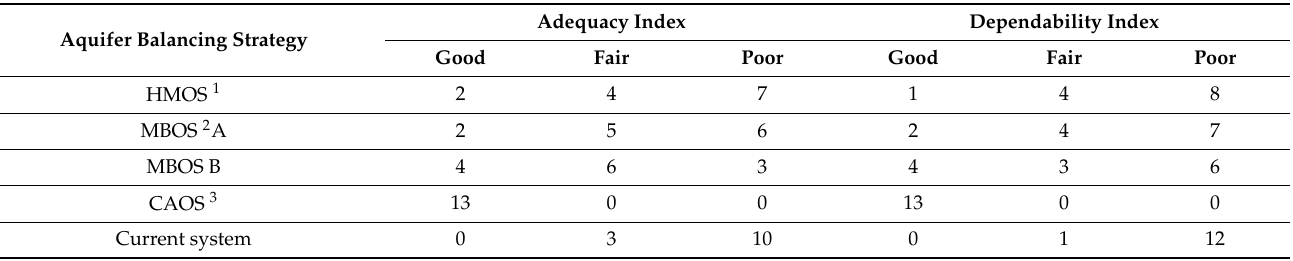
Table 2. Number of reservoirs in the Nekouabad surface water distribution system in each category of adequacy and dependability indices of water distribution after the application of the strategies in a normal scenario.